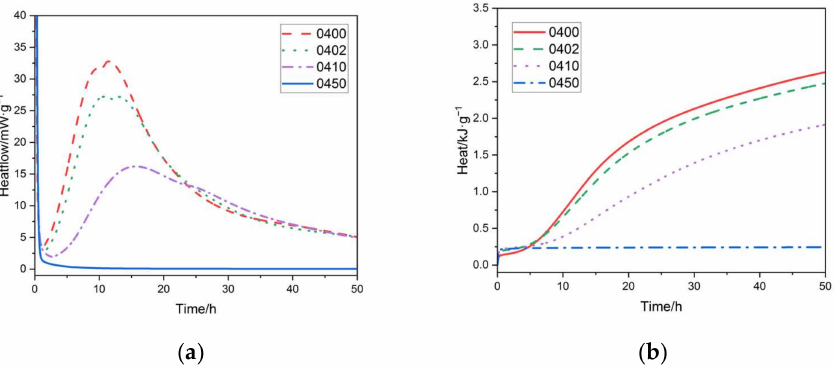
Figure 7. ( a ) Rate of hydration heat release of cement paste (W/C = 0.4) with different content of PEG-600. ( b ) Hydration heat curves of cement paste (W/C = 0.4) with different content of PEG-600.